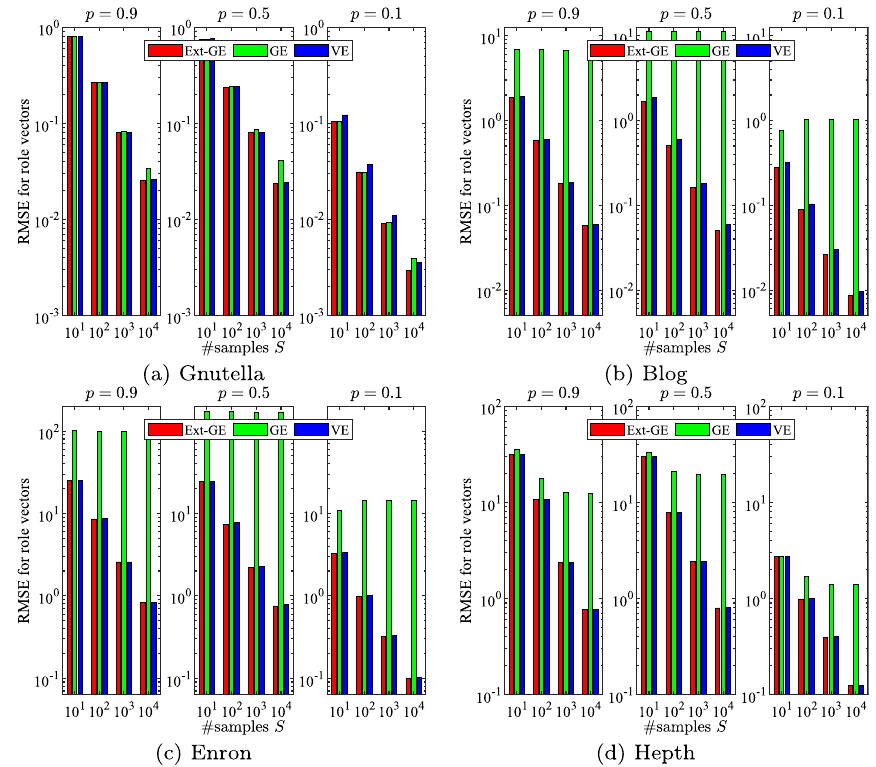
Fig. 5 RMSE of ensembled role vectors ¯ R against true role vectors